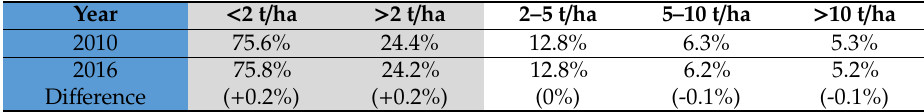
Table 3. Percentage (%) in di ff erent soil loss classes for 2010 and